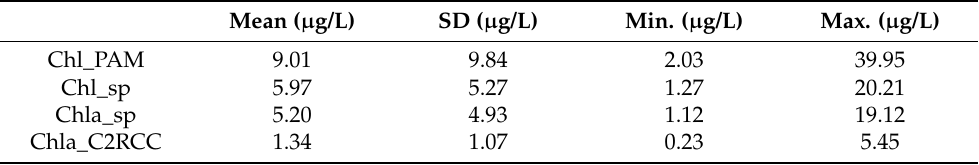
Table 2. Statistical description (mean, standard deviation, minimum, and maximum) of concentration measurements (pooled results across all sites and dates): total chlorophyll concentration measured with the Phyto-PAM instrument (n = 42), total chlorophyll and chlorophyll-a measured spectrophoto- metrically (n = 27), chlorophyll-a measured with the Case-2 Regional CoastColour (C2RCC) processor (n = 32). The complete dataset can be found in Table S2, Supplementary